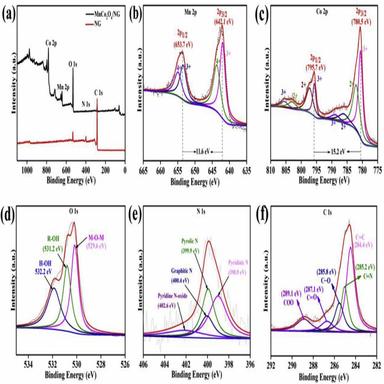
(a) XPS spectra of MnCo2O4/NG 2D/2D hybrid nanoarchitectures and NG, (b) Mn 2p, (c) Co 2p, (d) O 1s, (e) N 1s, and (f) C 1s of MnCo2O4/NG 2D/2D hybrid nanoarchitectures.